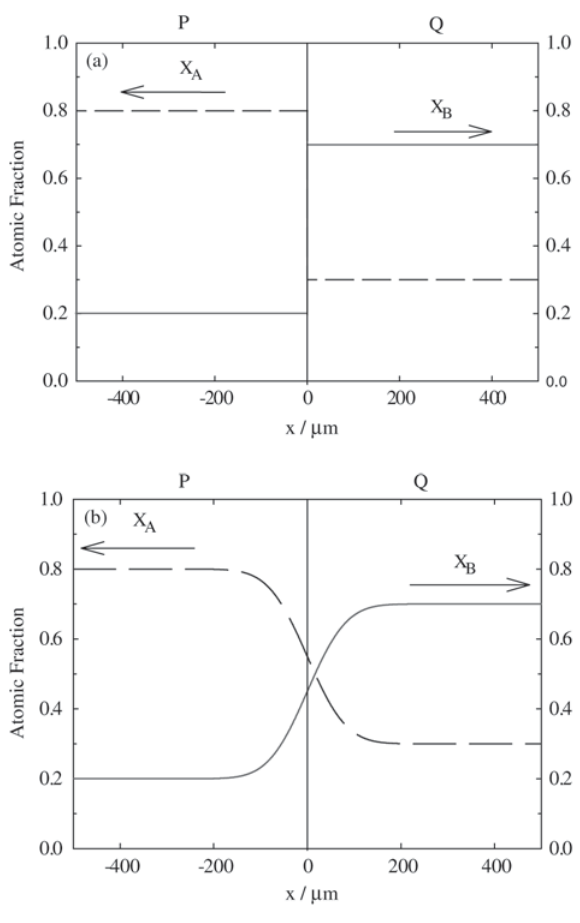
Figure 1. Composition distribution in a diffusion couple: a) be- fore and b) after the isothermal anneal. An error function was employed to generate the composition profile where the inter- diffusion coefficient, D o = 10 -9 cm 2 /s, and the time for the diffu- sion anneal, t = 6 h. Figure 2. Interdiffusion flux in a flowing